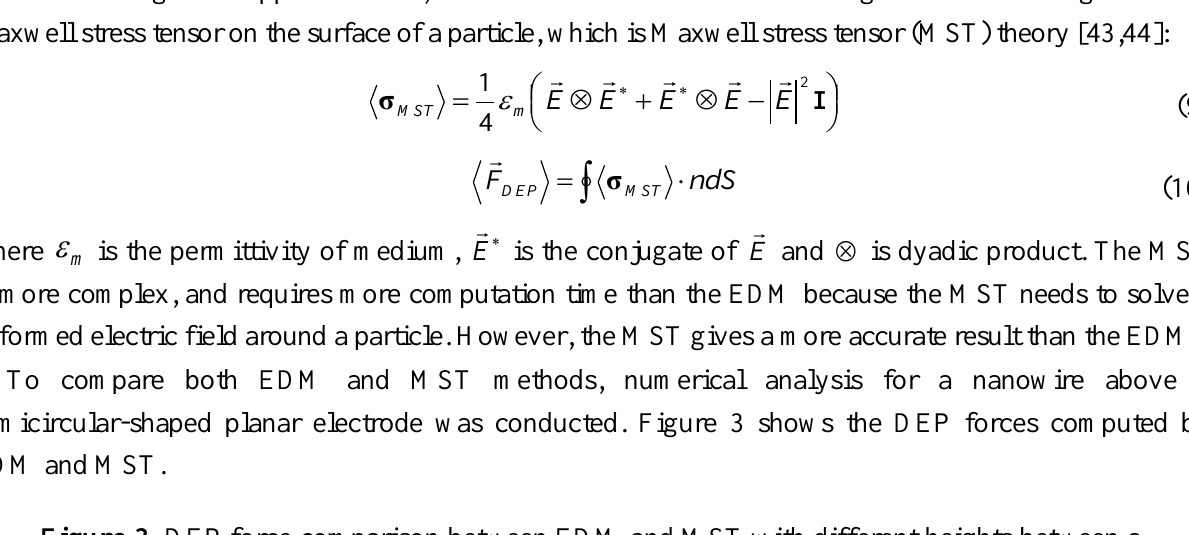
Figure 3. DEP force comparison between EDM and MST with different heights between a particle and electrode surface ( a ) Particle length is 0.5 μm; ( b ) Particle length is 2.0